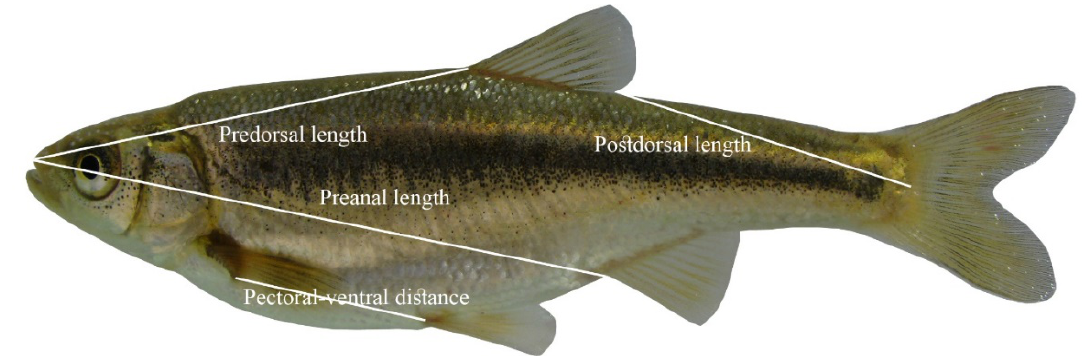
F IGURE 2. A photo of Alburnus mossulensis with some morphometric